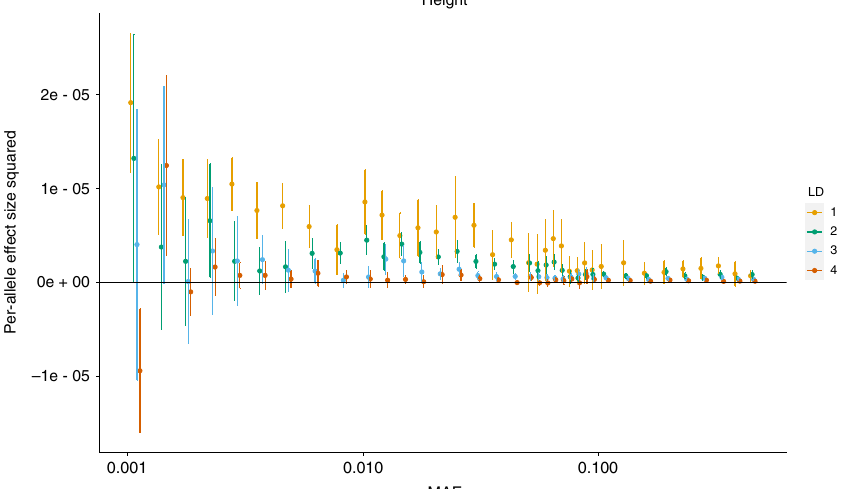
Fig. 5 Per-allele squared effect size of height as a function of MAF. We applied RHE-mc to N = 291,273 unrelated white British individuals and M = 7,774,235 imputed SNPs. SNPs were partitioned into 144 bins based on LD score (4 bins based on quartiles of the LD score with i denoting the i th quartile) and MAF (36 MAF bins) (see “ Methods ” section). Per-allele effect size squared for bin k is de fi ned as h 2 k M bin k , M k is the number of SNPs in bin k , and f k is the average MAF in bin k . Each point represents the estimated allelic effect size. Bars mark ±2 standard errors centered on the estimated allelic effect size. See Supplementary Fig. 9 for results on all 22